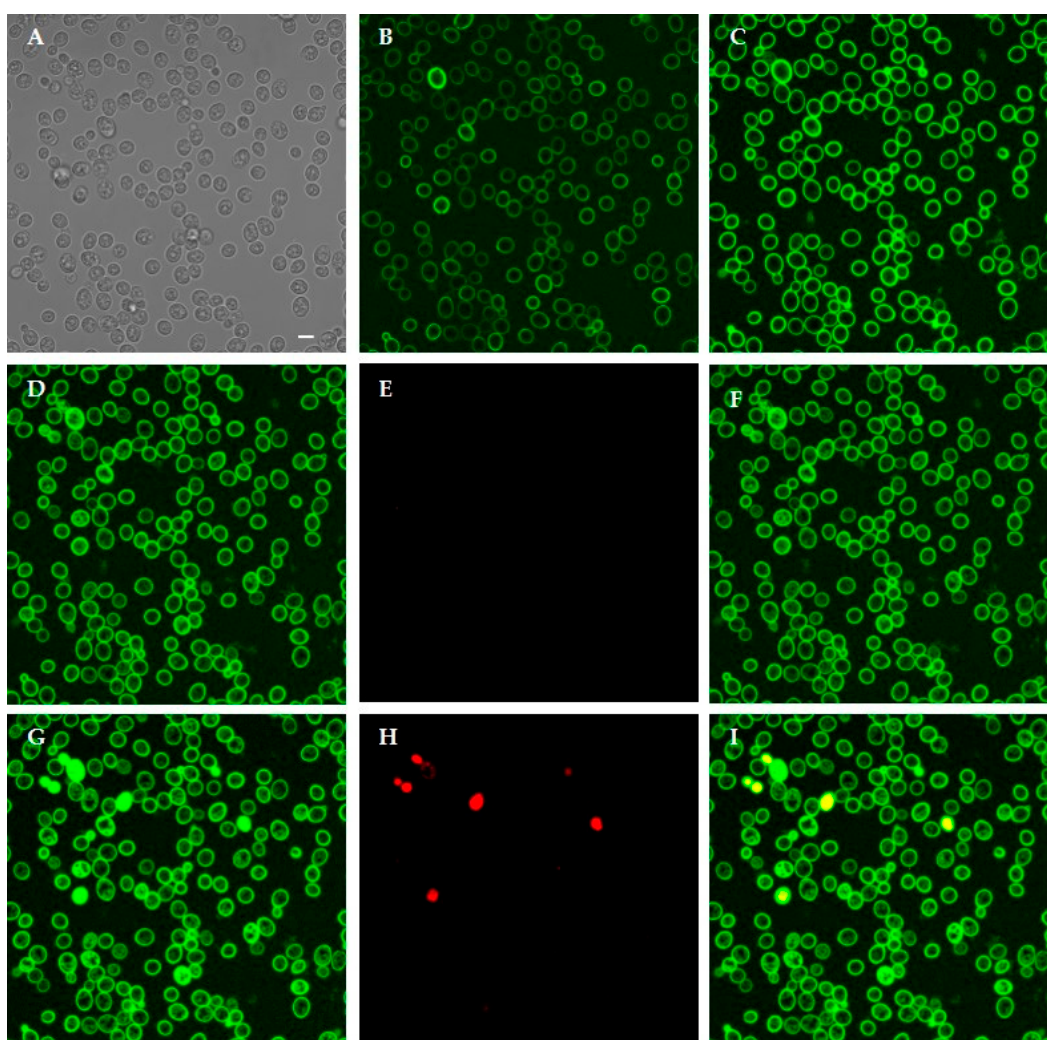
Figure 10. Interaction between living Candida albicans cells and FITC-labeled K10S. Confocal microscopy images of yeast cells incubated with the labeled peptide for 15 and 100 min are shown in ( B , C ), respectively. K10S was mainly bound to yeast cell wall. In ( A ), the same field is shown in light transmission. After 150 min, K10S entered viable yeast cells: ( D ) FITC; ( E ) PI; ( F ) merge of ( D , E ). Intensely fluorescent dead cells were observed after 180 min, as demonstrated by PI internalization: ( G ) FITC; ( H ) PI; ( I ) merge of ( G , H ). Bar, 5 µm.